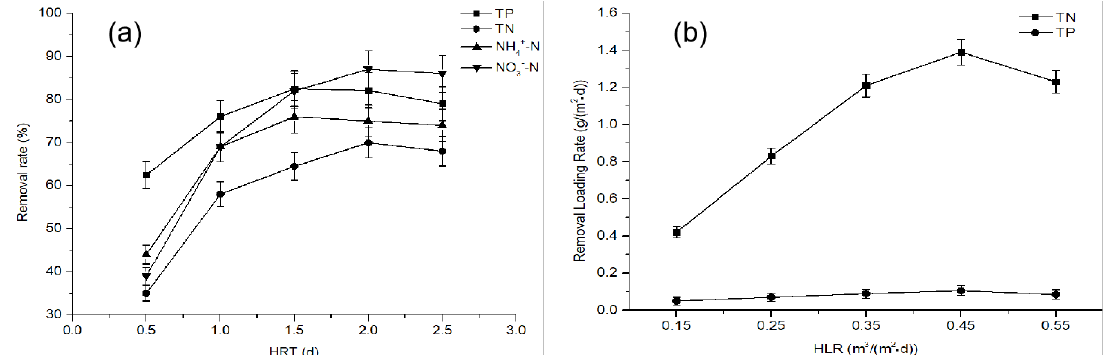
Figure 3. Effects of HRT (Hydraulic Retention Time) and HLR (Hydraulic Loading Rate) on target pollutant removal rate, ( a ) Effects of HRT on the target pollutant removal rate, ( b ) Effects of HLR on the target pollutant removal loading rate.